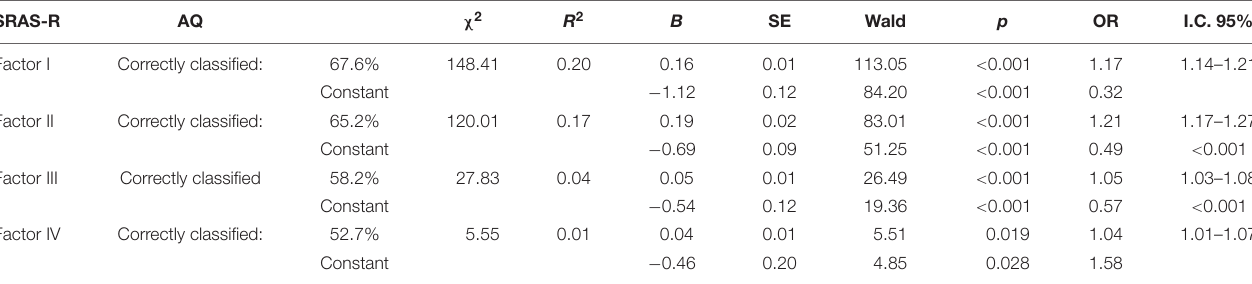
TABLE 9 | Logistic regression model for the probability of presenting high Hostility based on the school refusal behavior.